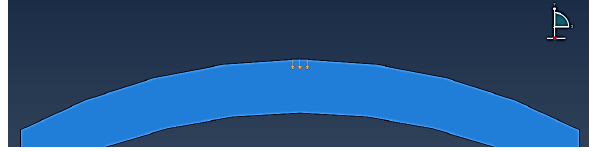
Figure 5: Numerical boundary conditions in the upper part of the segment